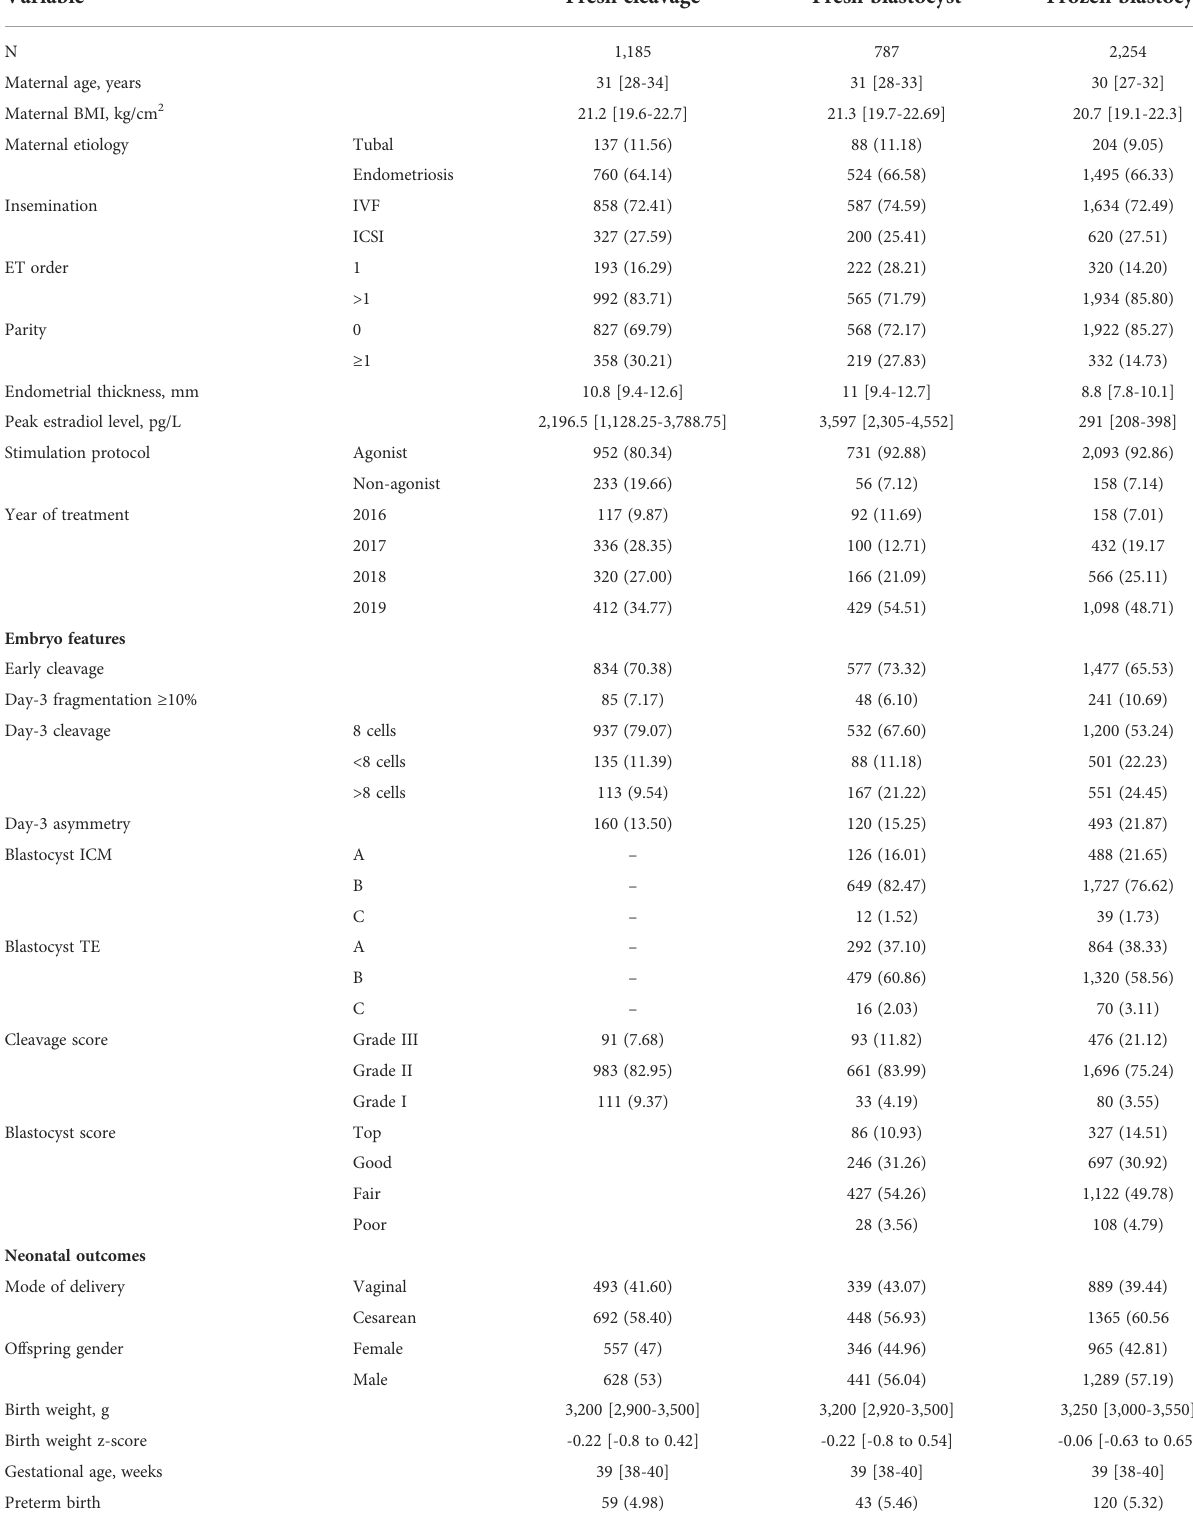
TABLE 1 Patients ’ characteristics and neonatal